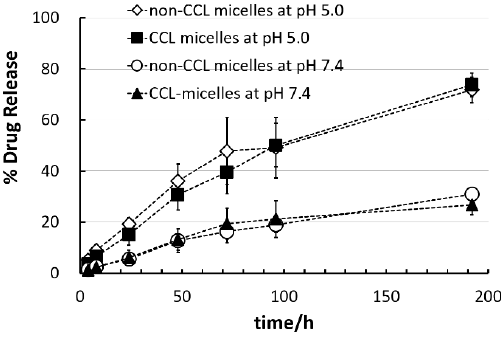
Figure 6. Release of Adriamycin from polymeric micelles in different media where either pH = 7.4 ( D -PBS) or pH = 5.0 (acetate buffer). Diamonds and squares indicate the after and before photo-irradiation contexts, respectively. The release assay was performed in triplicate.